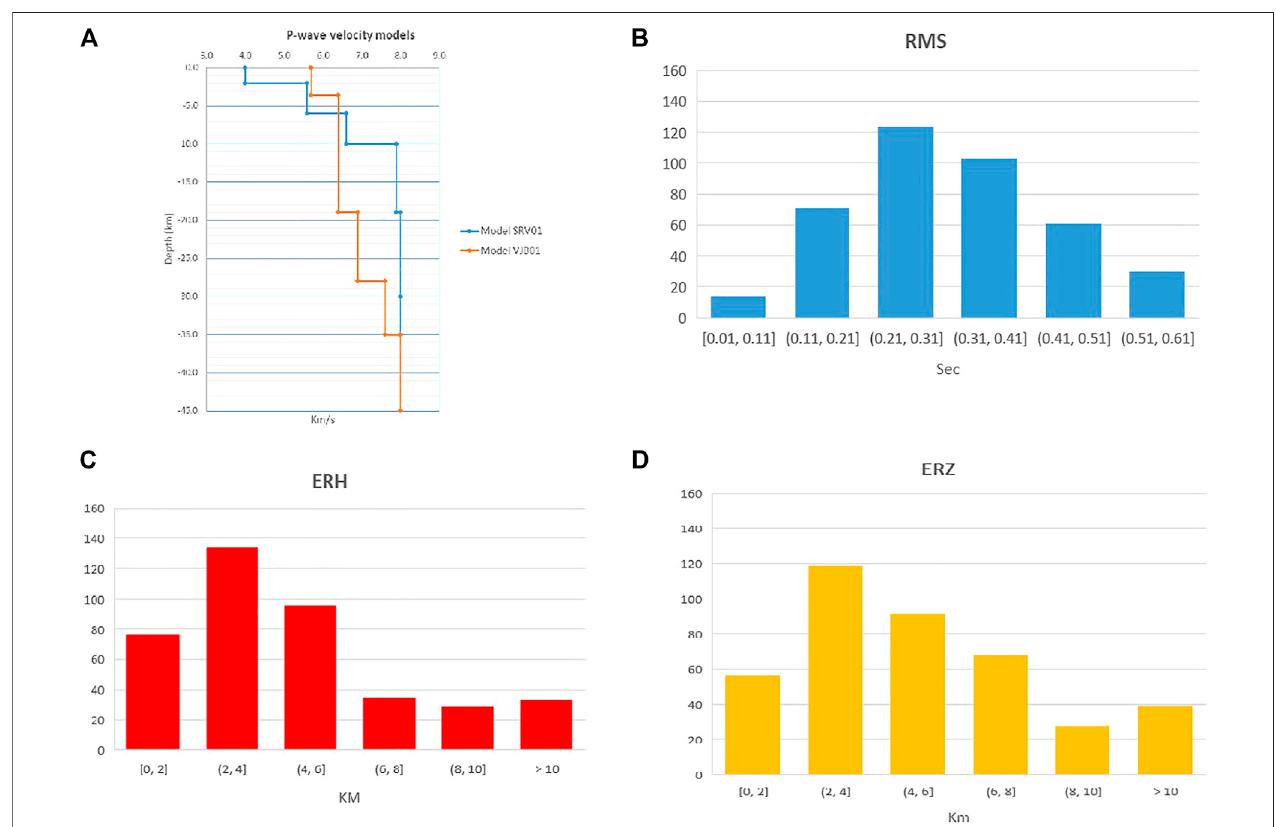
FIGURE4|(A) ComparisonbetweenP-wavevelocitymodelsVJB01andSVRV01.ModelrelocationerrorsforOBSdatausingHypo71withSVR01velocitymodel: (B) RMS; (C) ERH; (D) ERZ.